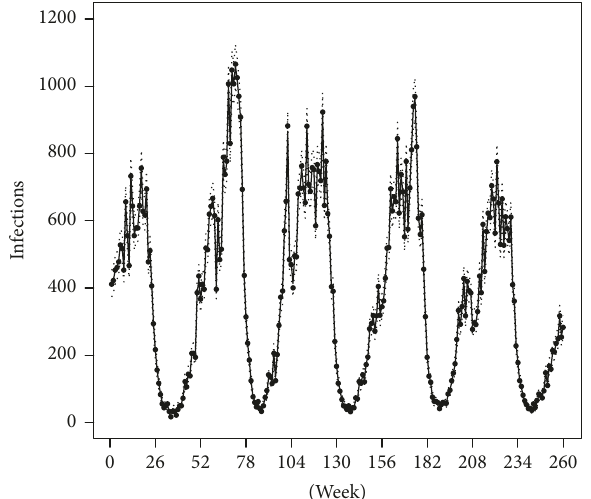
Figure 5: Reported cases of chickenpox (solid points) together with posterior means (solid line) and 95 % credible intervals (dotted line) from week 4, 2007, to week 3, 2012.